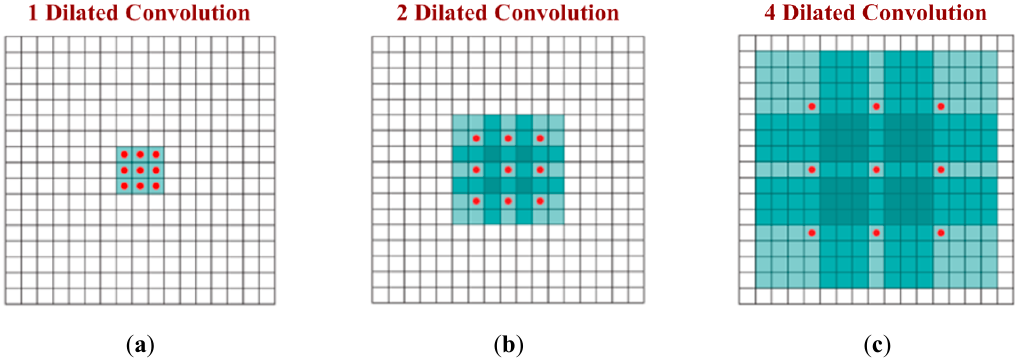
Figure 5. Dilated convolution: ( a ) receptive field of 3 × 3 using 1-dilated convolution; ( b ) receptive field of 7 × 7 using 2-dilated convolution; ( c ) receptive field of 15 × 15 using 4-dilated convolution.